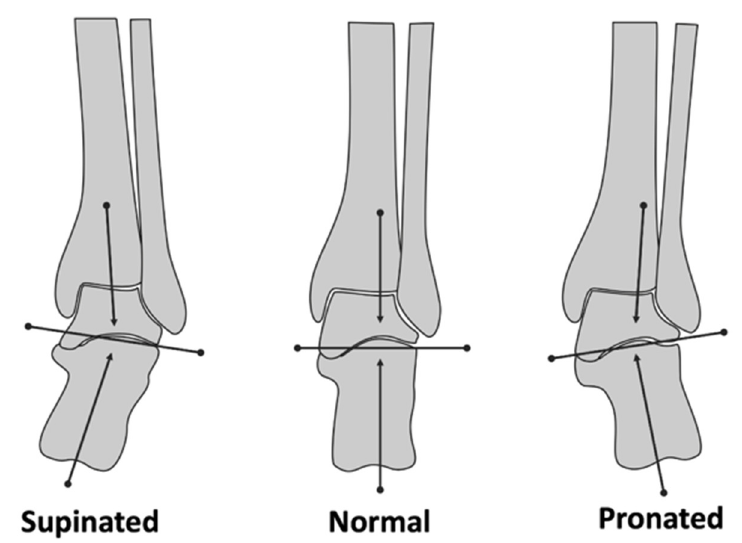
Figure 2. Differences in foot and ankle alignment.